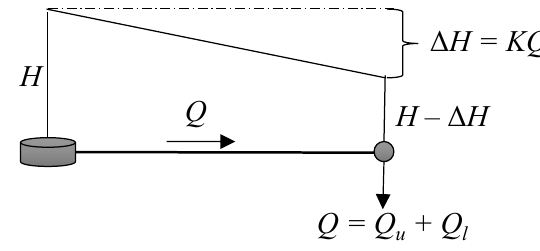
Figure 2. Energy balance for single pipe network.